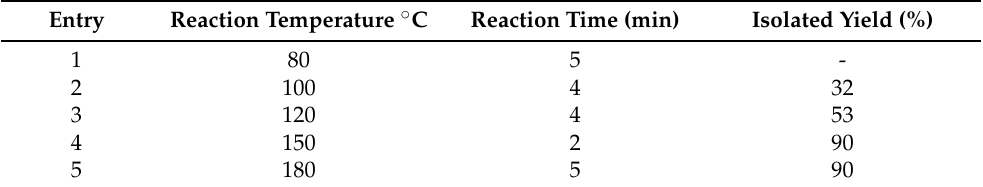
Table 2. Temperature optimization for the synthesis of 3c using MW at 300 W.